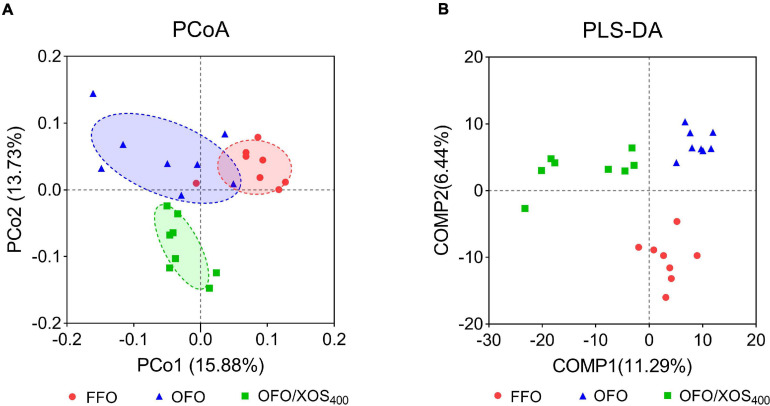
Beta-diversity analysis of cecal microbiota among three groups. (A) Principal coordinate analysis (PCoA) based on unweighted UniFrac distance calculated from OTU abundance matrix. The horizontal axis represents the first principal coordinate, and the vertical axis means the second one. (B) Partial least squares discriminant analysis (PLS-DA). The horizontal axis represents the first component of PLS-DA, and the vertical axis means the second one. The percentages in parentheses represent the explanatory values of the principal coordinates or the components for the difference in sample composition. FFO (red circles), fresh fish oil diet; OFO (blue triangles), oxidized fish oil diet; OFO/XOS400 (green rectangles), oxidized fish oil diet + 400 mg/kg xylooligosaccharide.